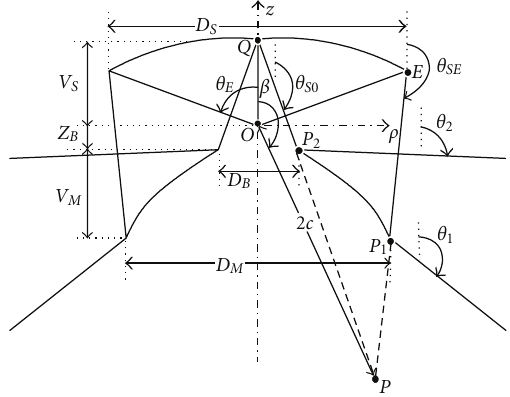
Figure 2: Basic geometry of the OADC antenna with shaped main